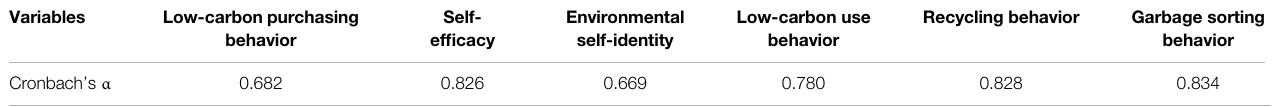
TABLE 1 | Cronbach ’ s α .